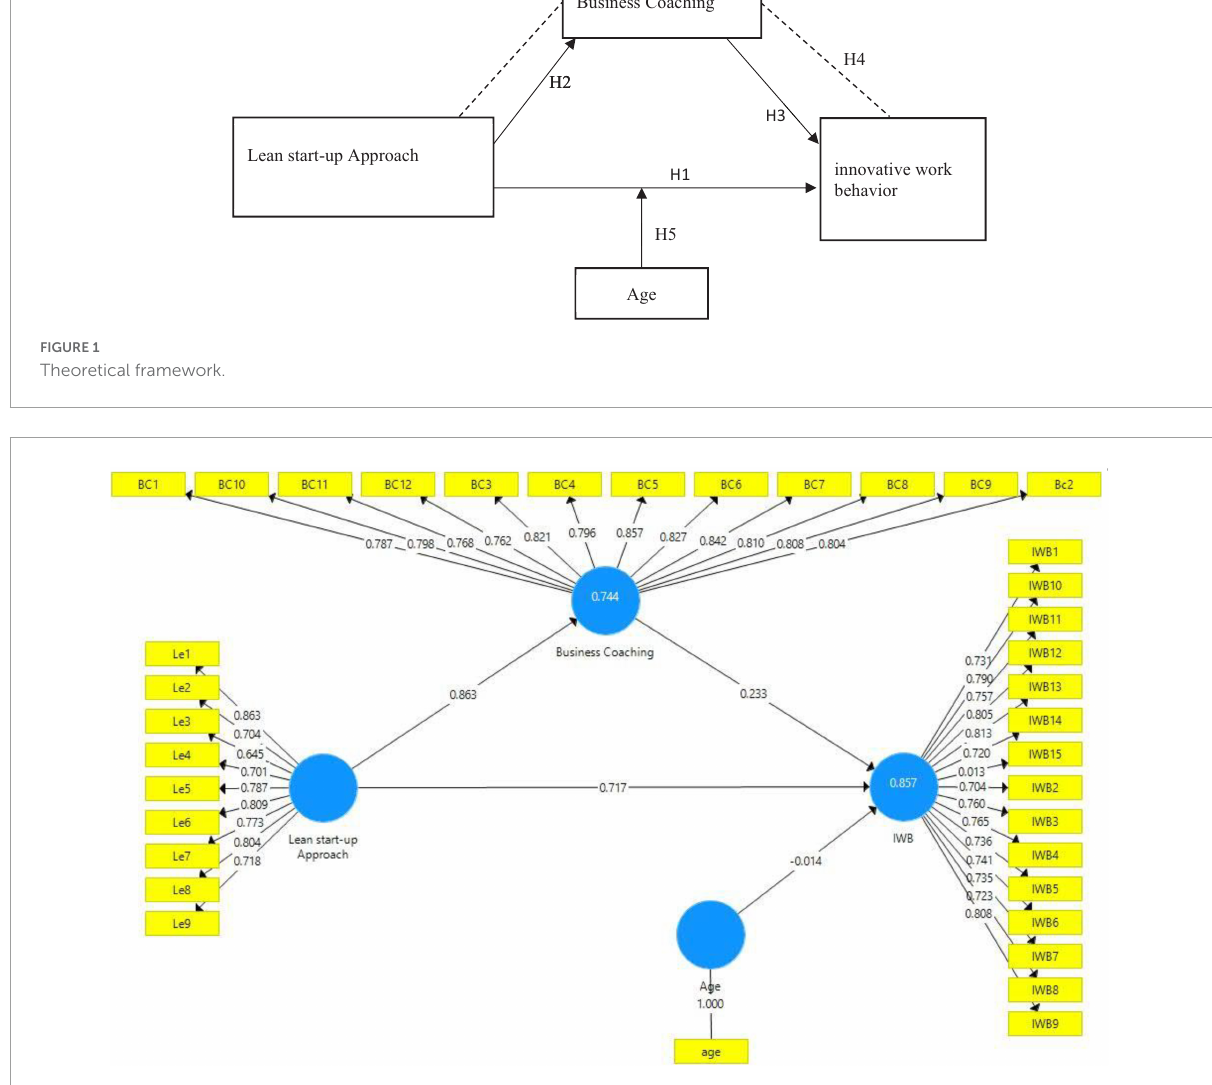
FIGURE2 Measurement